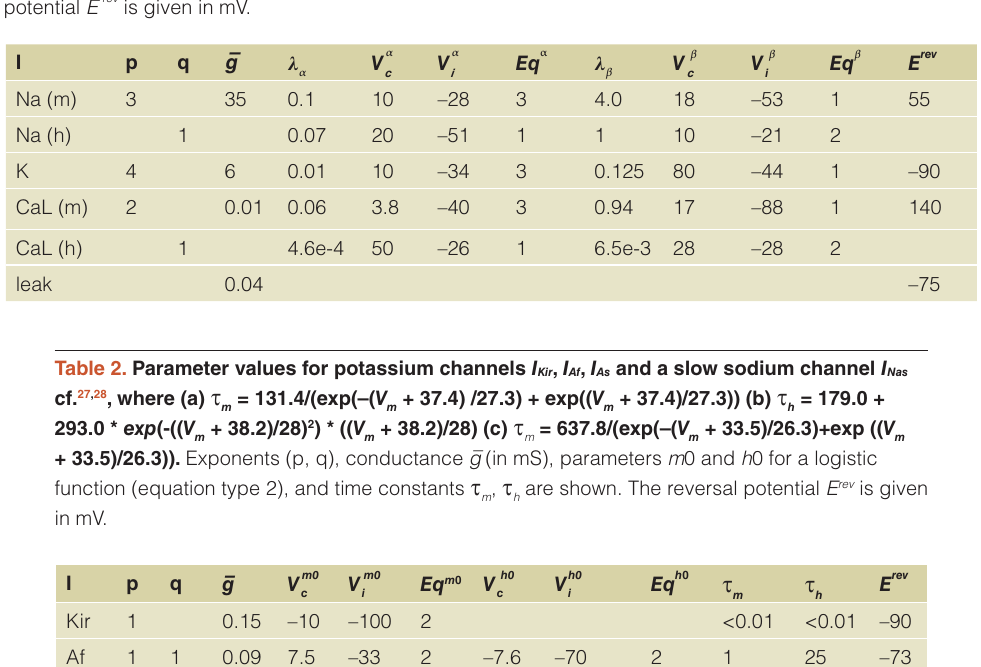
+ 37.4)/27.3)) (b) τ m